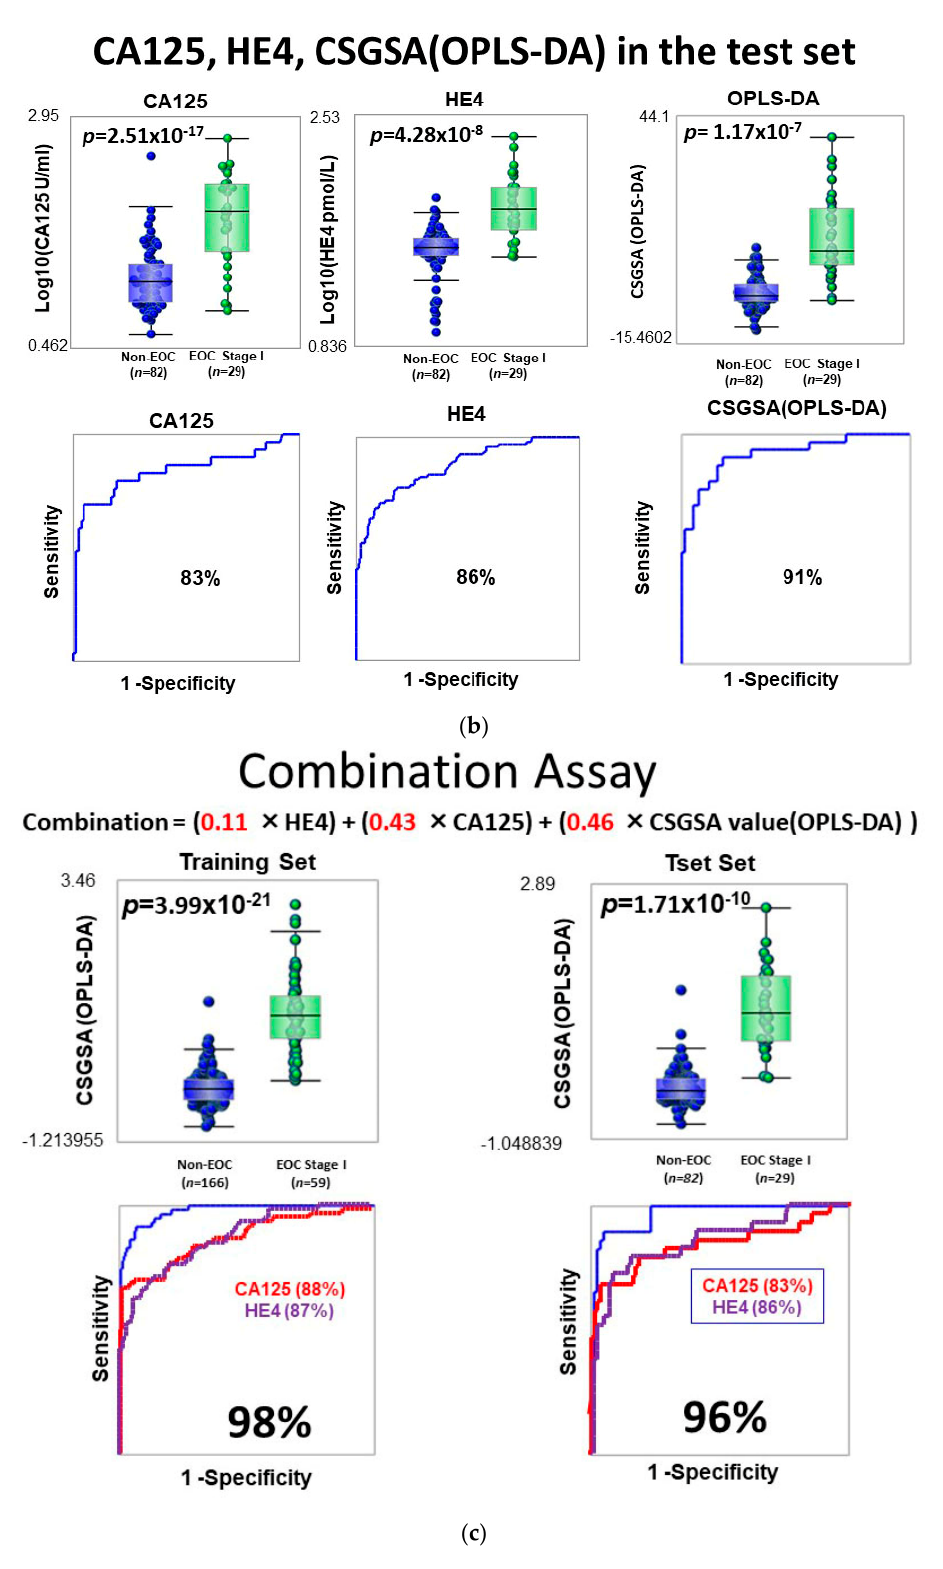
Figure 1. Test set: biomarker performance for the detection of stage I epithelial ovarian cancer (EOC) versus non-EOC control. ( a ) Orthogonal partial least-squares discriminant modeling (OPLS-DA) scatter plot for stage I EOC (green dots) and non-EOC control (blue dots) samples. When the test sample data set was evaluated using the trained model (Figure S2), a better differentiation was achieved in the test set between EOC ( n = 29) and non-EOC patients ( n = 82). Definition of comprehensive serum glycopeptide spectra analysis (CSGSA (OPLS-DA)): data structure was constructed using 1712 glycopeptide levels obtained from 225 examinees (training set: 1712 × 225 matrix), which was geometrically assumed as